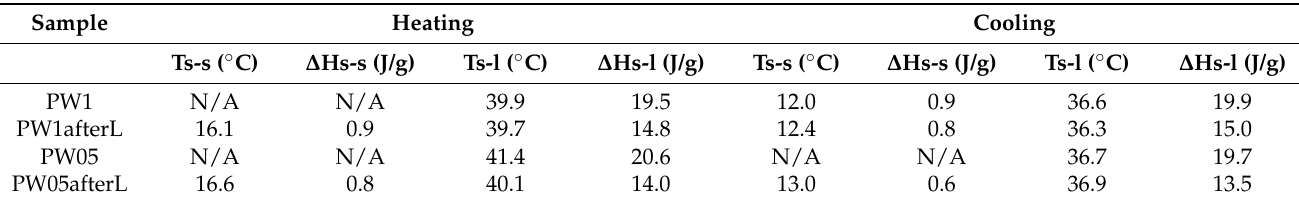
Table 6. DSC analysis of PW1 and PW05 foams before and after